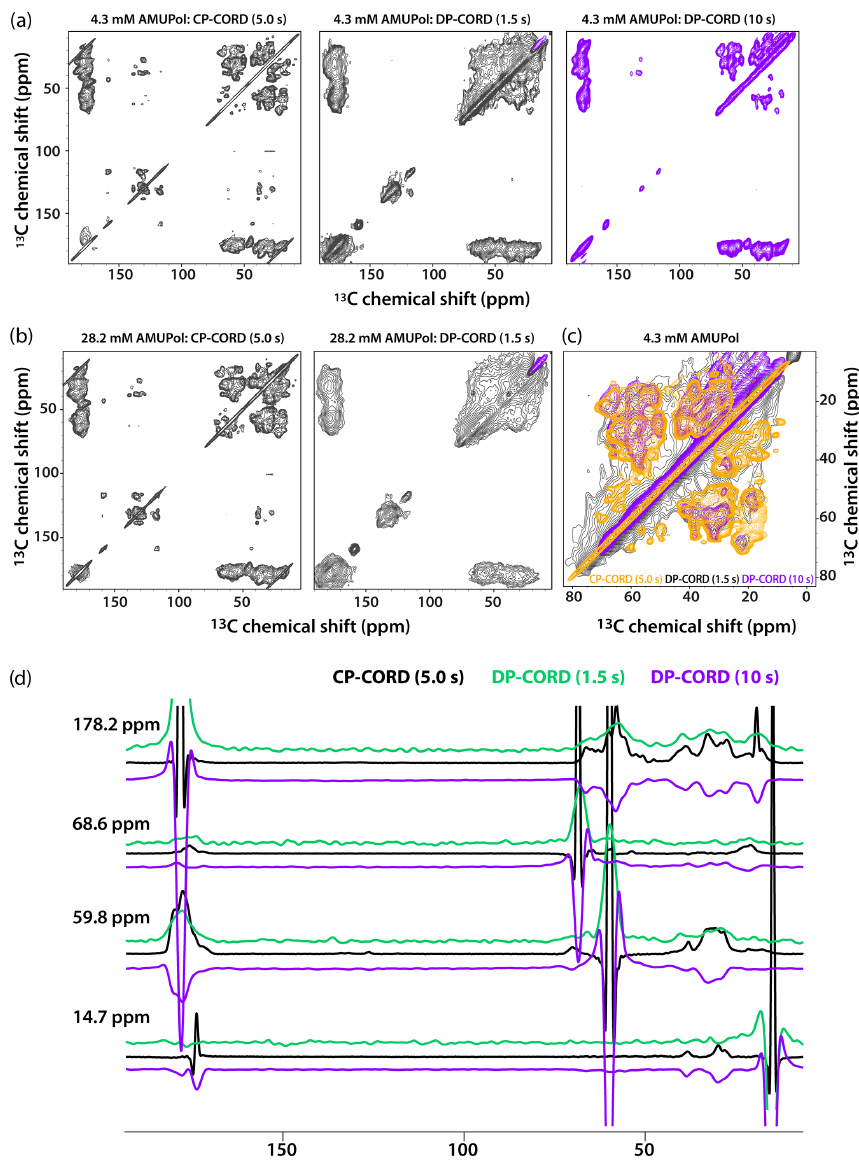
Figure 5. DNP-enhanced CP-CORD (left) and DP-CORD (middle and right) spectra of 5F-Trp, U- 13 C, 15 N tubular CA assemblies in the presence of 4.3mM AMUPol (a) and 28.2mM AMUPol (b) . The recycle delay in the CP-CORD spectra was 5s, in the DP-CORD spectra 1.5s (middle) and 10s (right). The CORD mixing time was 20ms. The positive and negative signals are shown in black and magenta, respectively. (c) The superposition of DNP-enhanced spectra shown in (a) : CP-CORD (gold), DP-CORD with a recycle delay of 1.5s (black), and DP-CORD with a recycle delay of 10s (magenta). (d) Representative 1D traces extracted from 2D CP-CORD (black), DP- CORD (recycle delay 1.5s, green), and DP-CORD (recycle delay 10s, purple) spectra of 5F-Trp, U- 13 C, 15 N tubular CA assemblies in the presence of 4.3mM AMUPol. All spectra were acquired at 14.1T (150.96MHz 13 C Larmor frequency) at a MAS frequency of 24kHz and